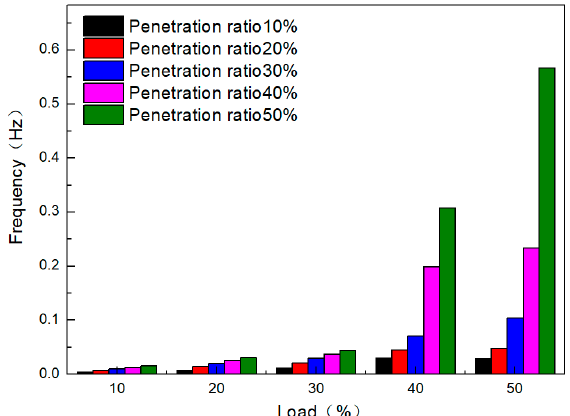
Figure 10. Influence of PV penetration and load change on the difference between peak and valley amplitude of grid frequency at nodes.